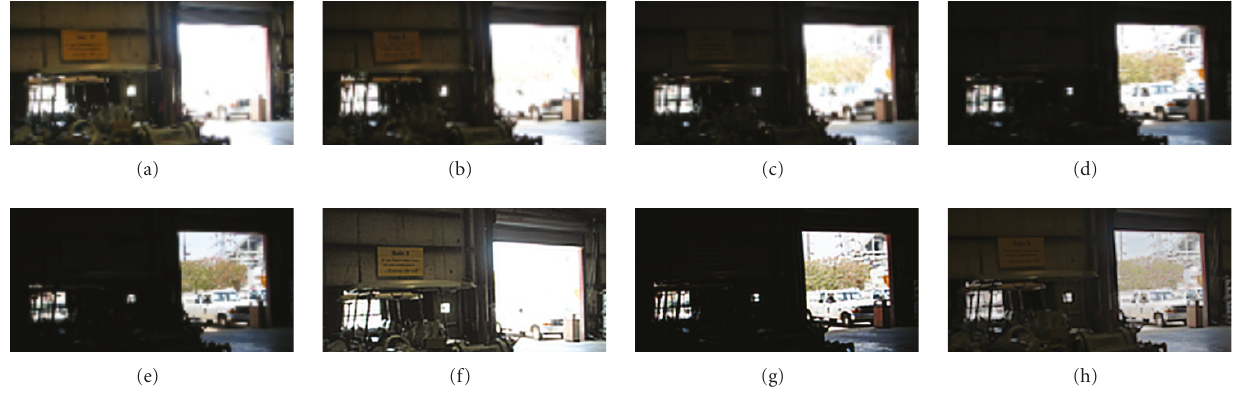
Figure 9: Cropped regions of observation and SR results: (a)–(e) input images; (f) SR when (a) is the reference image; (g) SR when (e) is the reference image; (h) SR using the technique presented in Section